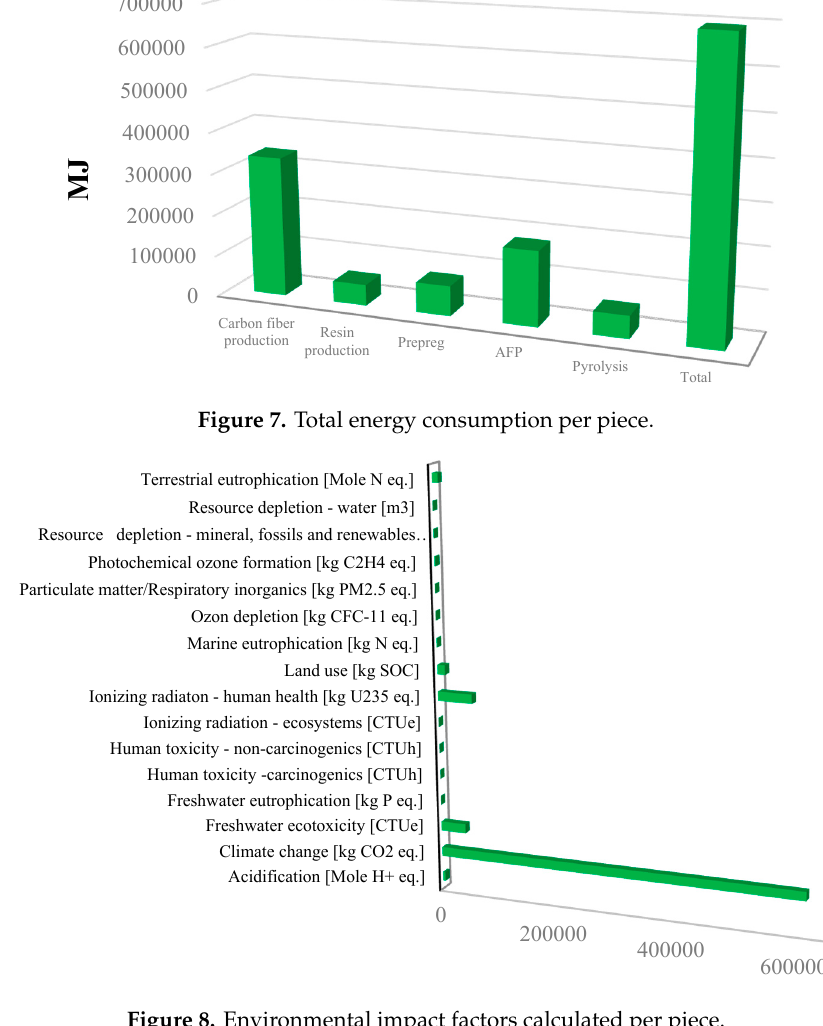
Figure 8. Environmental impact factors calculated per piece.